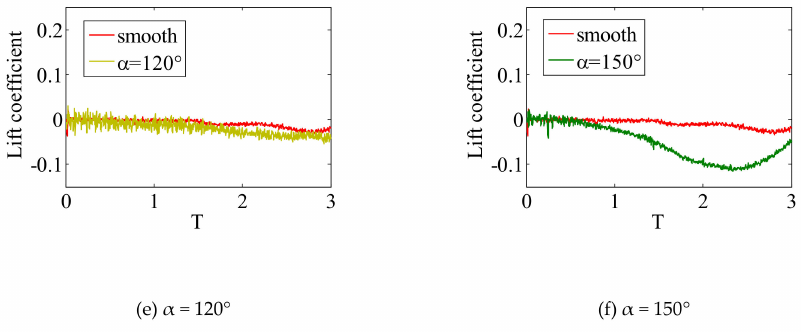
Figure 8. The comparison of the lift coe ffi cients between the smooth cylinder and cylinder with strips for Re = 55,000.